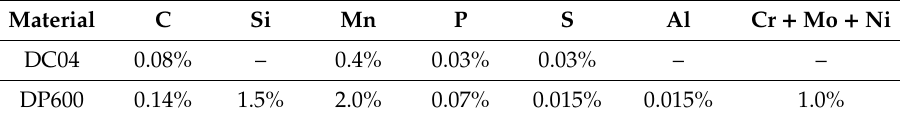
Table 1. Chemical components of DC04 [16] and DP600 [17].